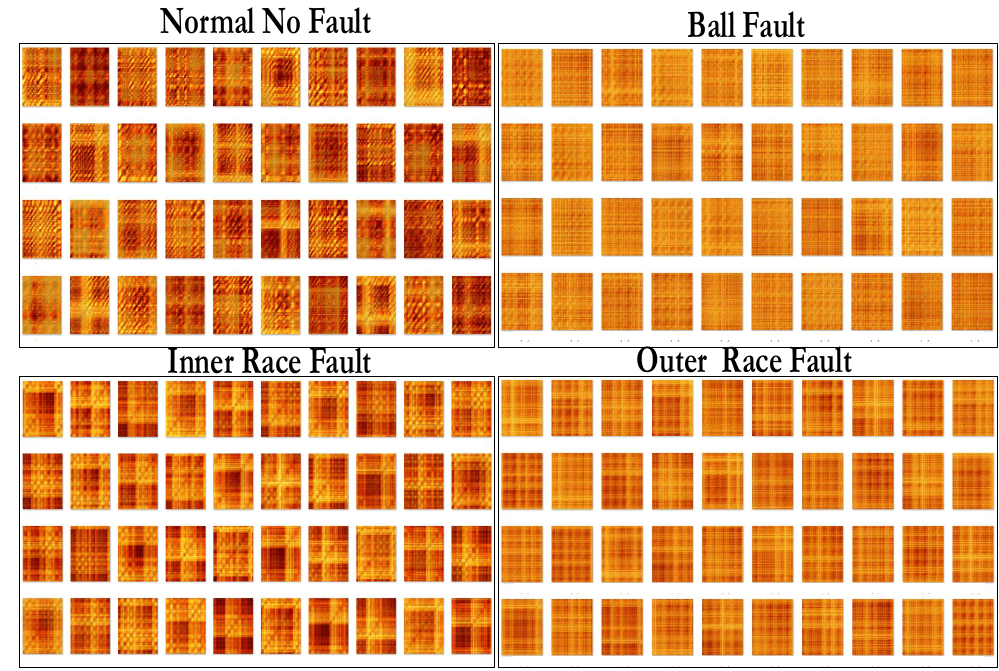
Figure 12. Images showing a subset of the images used for training the deep learning network. Data is divided into two bigger sets comprising fan end and drive end data,